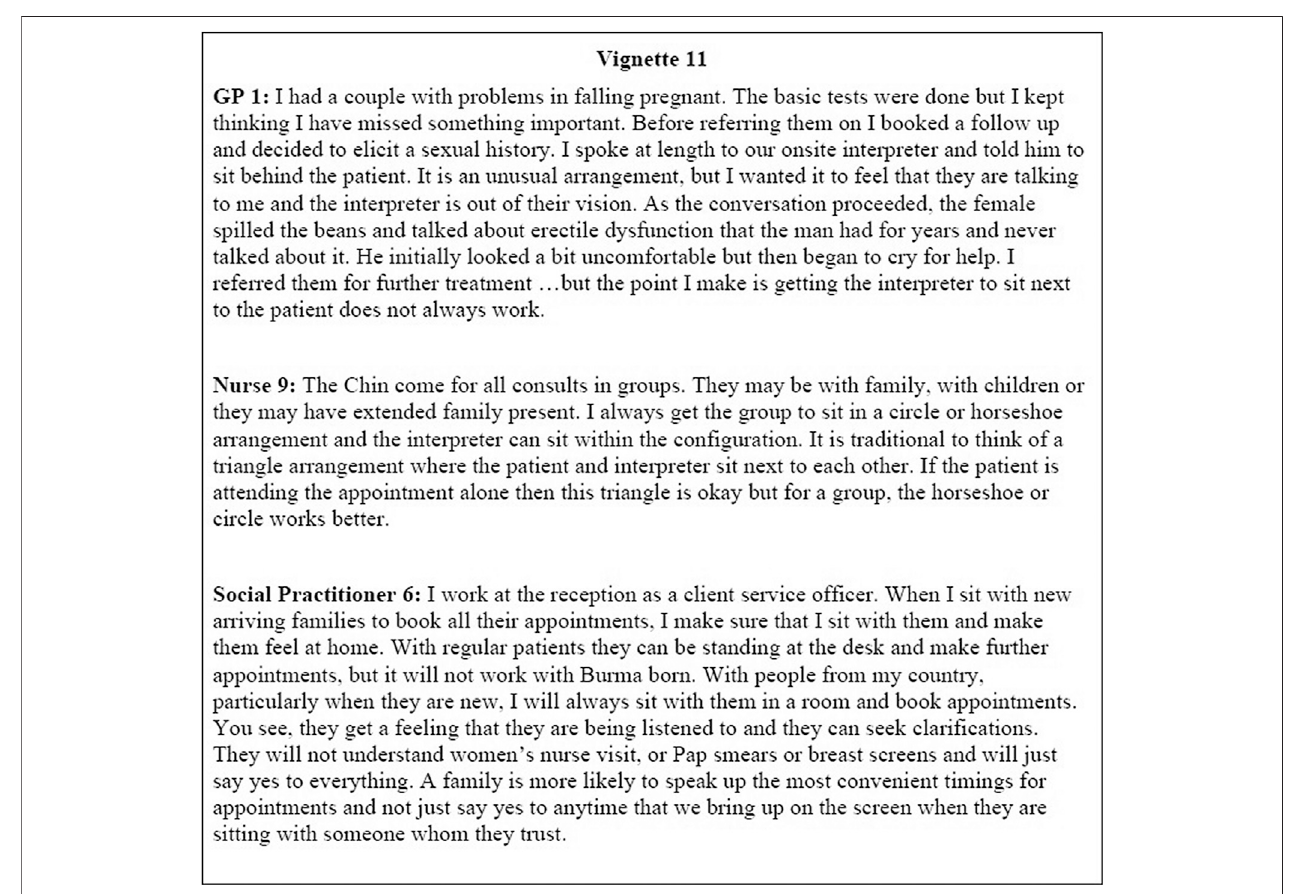
FIGURE 11 | Flexible room layouts for SRH